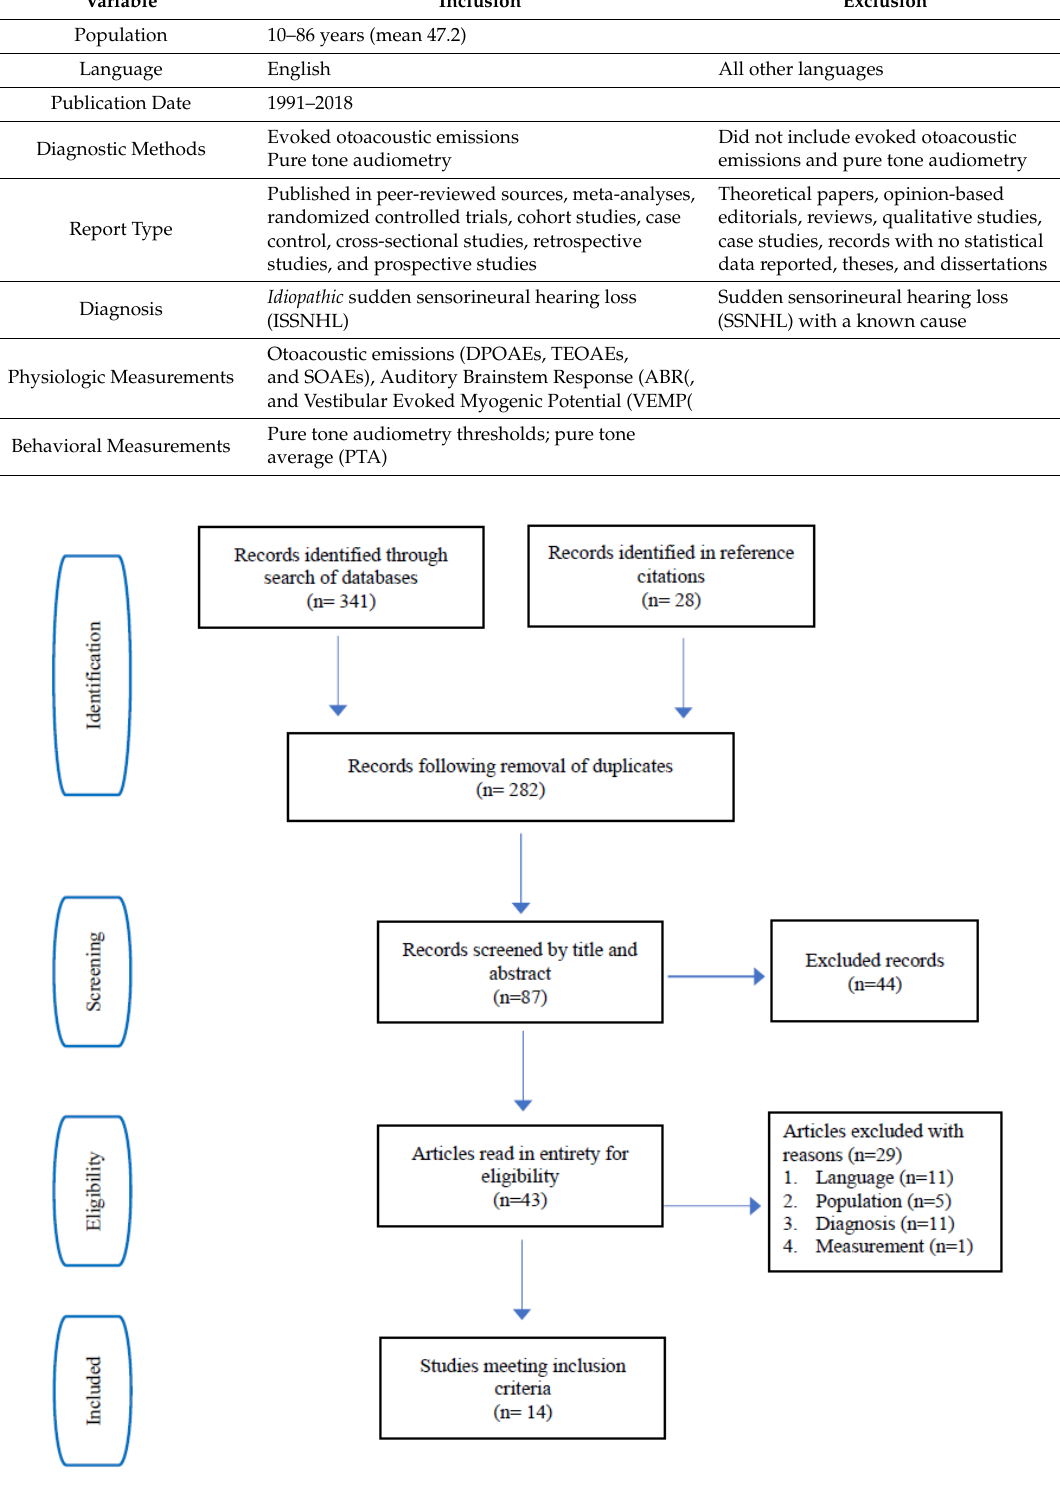
Figure 1. Comprehensive search process to identify included studies.